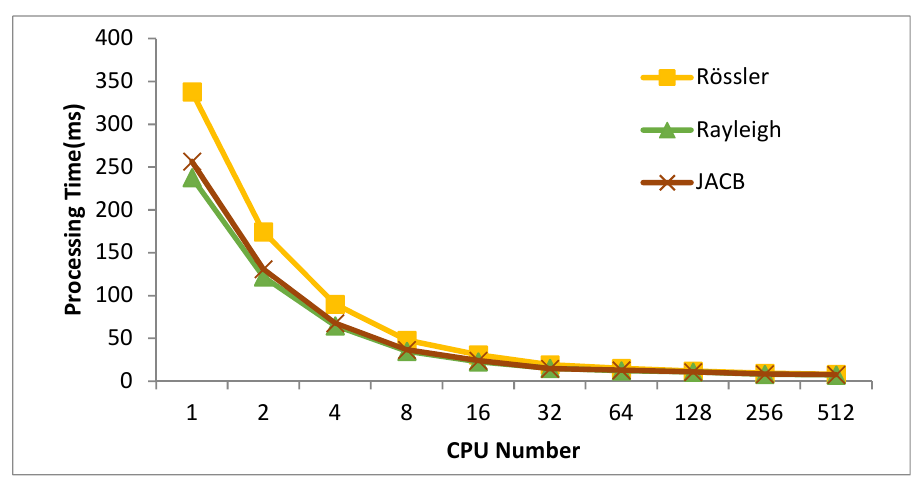
Figure 6. Effect of the number of processing units on the computing performance (for our novel approach PAMCL) for solving the Rössler attractor in GPU. The maximum error is 0.01.